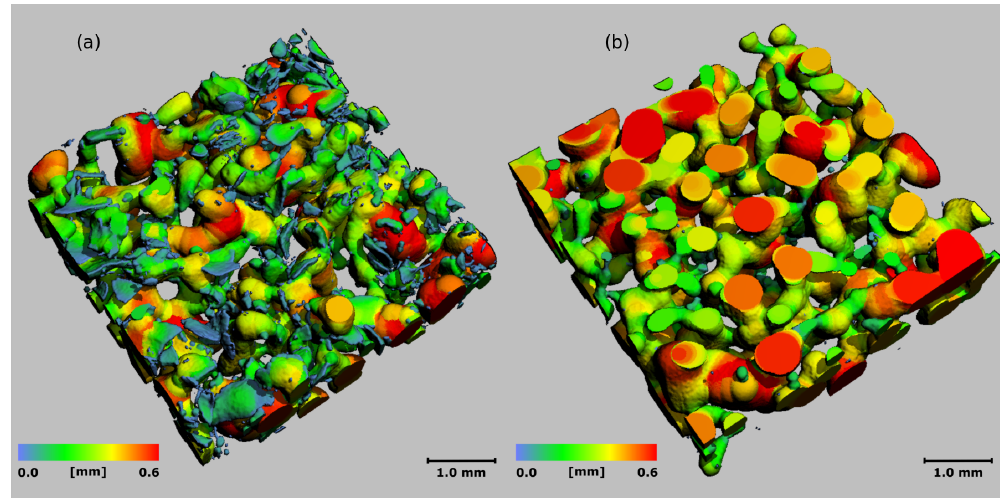
Figure 8. A three-dimensional reconstruction for a sample of snow type D taken with the micro-CT sampling kit (Fig. 5). We performed these measurements with the µCT 80 (55kVp, 15µm and 145µA). Panel (a) shows the sample surface scan with artificial particles ( < 0.5mm) prepared following the default IC sampling procedure. Panel (b) shows the snow grains ( > 0.5mm) scanned in the middle of the sample without the influence of the mechanical sampling treatment.